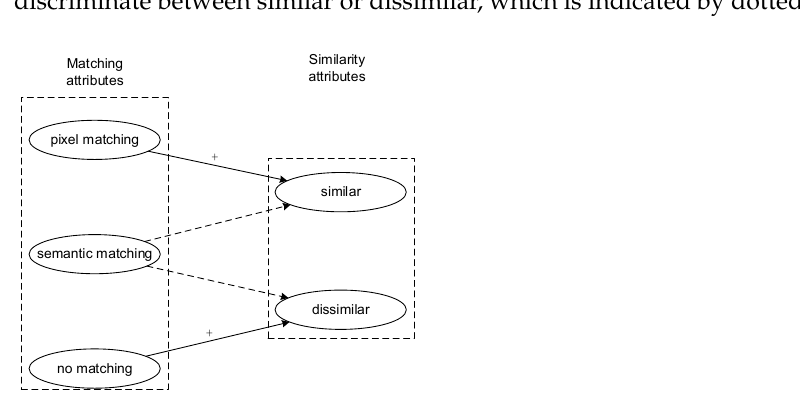
Figure 1. Relationship between match attribution and similarity attribution.